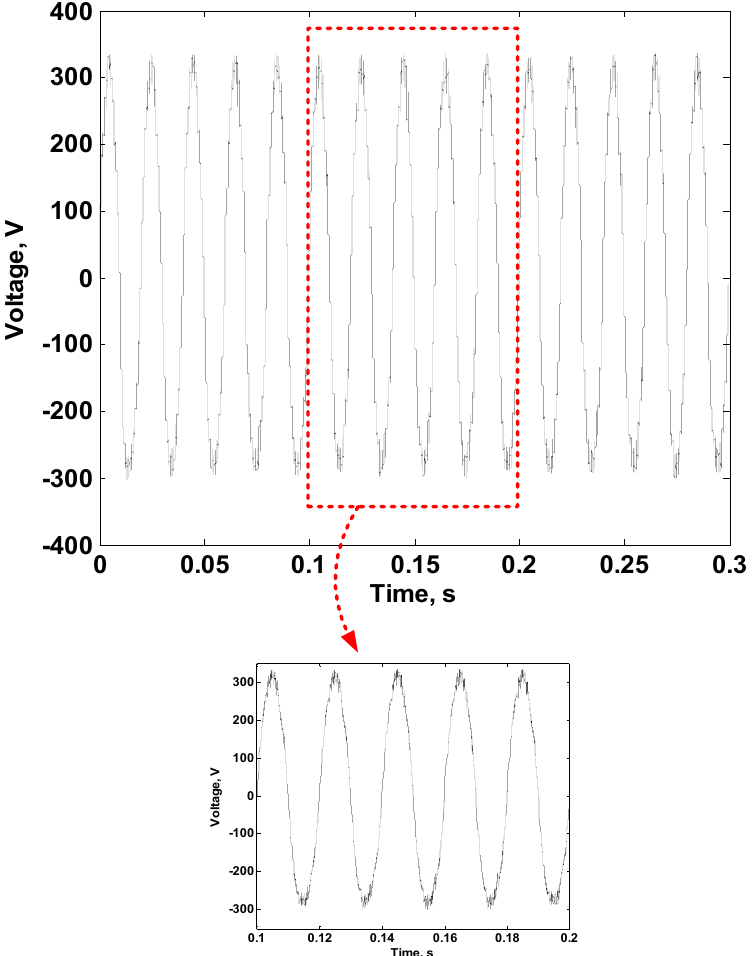
Figure 9. Conditions of 220 V, 50 Hz Sinusoidal Output Voltage.